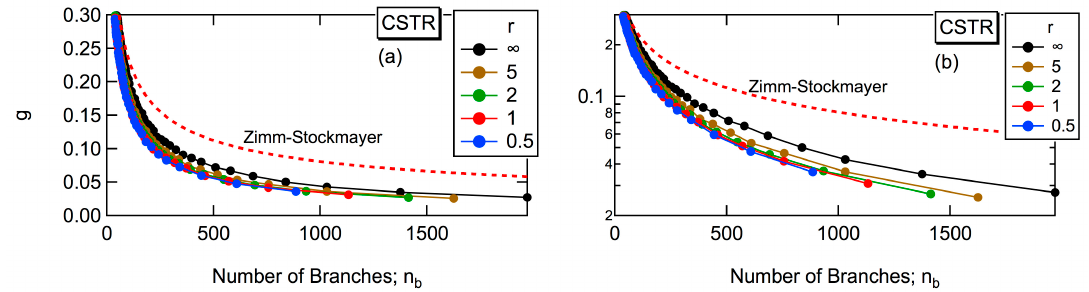
Figure 22. Expected g -ratio and n b for the HB polymers having n b branch points in a polymer with various reactivity ratio r for a CSTR. The plotted values are at ξ UL for each r . ( a ) Normal scale plot, and ( b ) logarithmic scale plot for the y-axis.